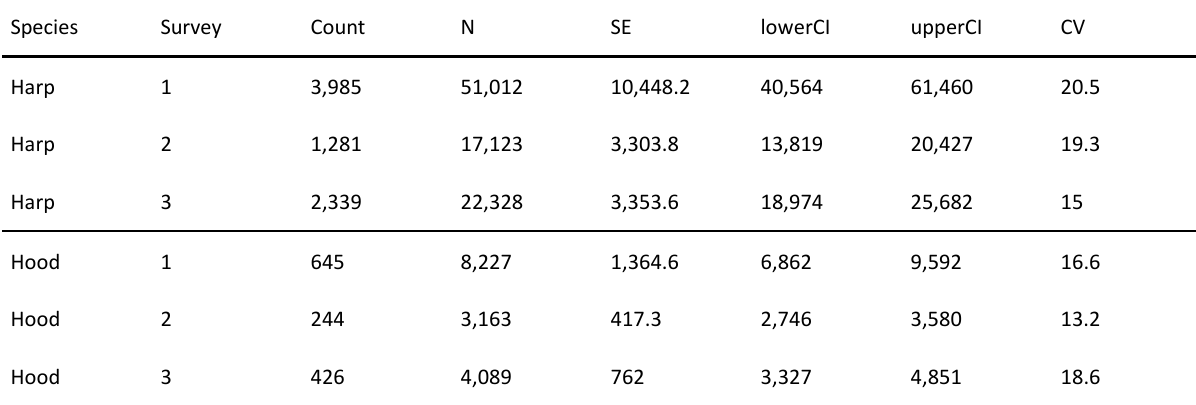
Table 3. Uncorrected pup production estimates for separate strata. Stratum 1: March 27, southern part, Stratum 2: March 28, northern part, northward, Stratum 3: March 28 southward at 2 nm spacing, Stratum 4: Strata 2 and 3 combined, 1 nm spacing, Stratum 1+4: Strata 1 and 4 combined. Species Stratum Count N SE lowerCI Harp 1 Harp 2 Harp 3 Harp Harp Hood Hood 325 Hood Hood